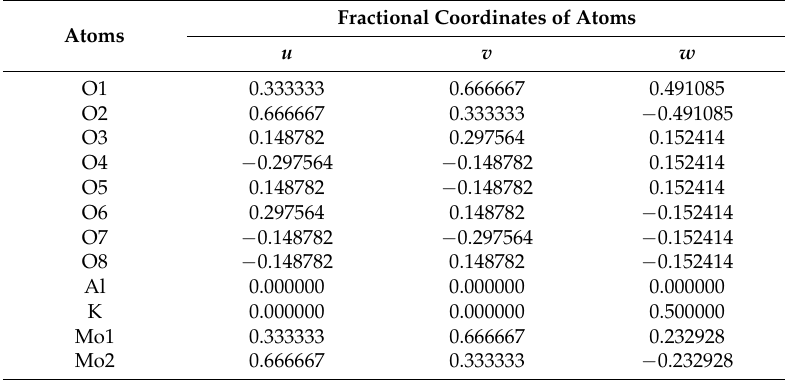
Table 2. The atomic coordinates of KAl(MoO 4 ) 2 crystal used for calculating Raman vibrational modes by CASTEP.